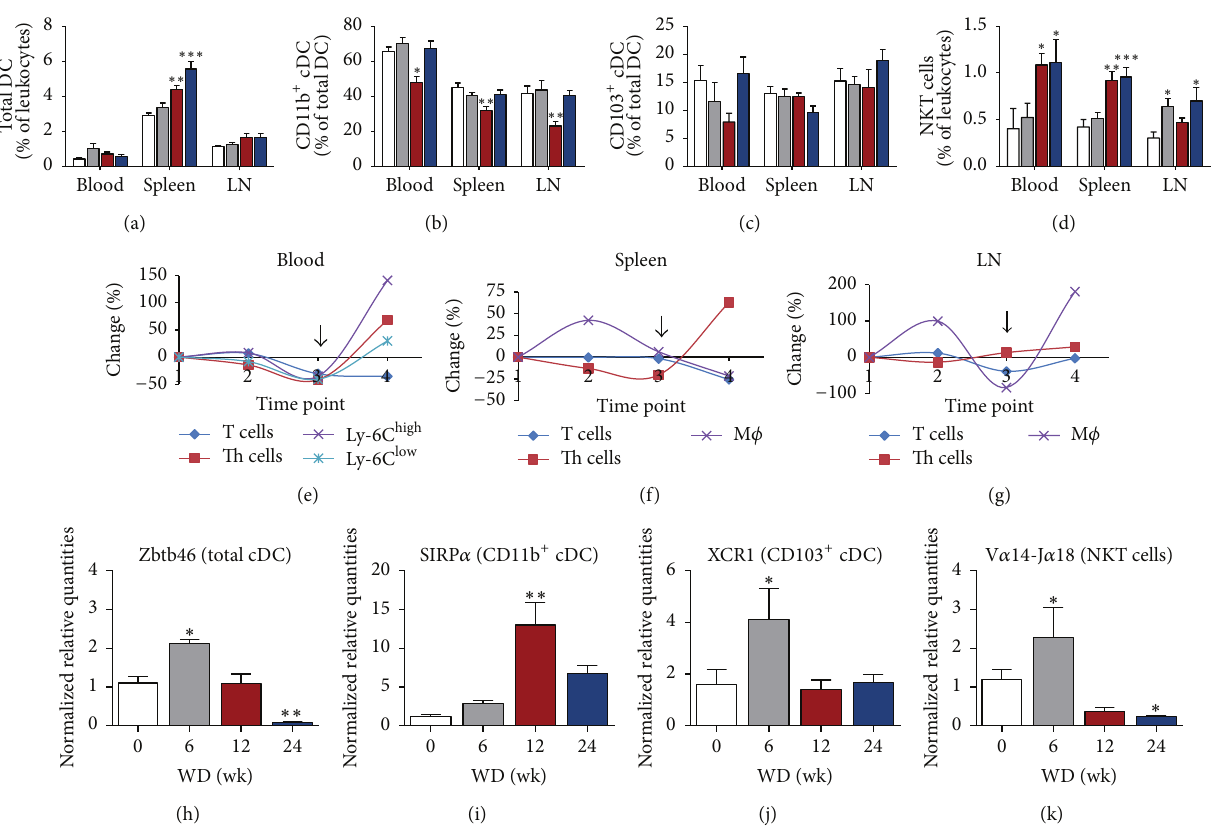
Figure2:Flowcytometryandgeneexpressionresultsofleukocyte(s)(subsets)inApoE −/− miceduringatherogenesis.Bargraphsrepresenting mice sacrificed after 0 wk (white bars, 𝑛 = 7 – 12 ), 6 wk (grey bars, 𝑛 = 9 – 12 ), 12wk (red bars, 𝑛 = 9 - 10 ), and 24 wk (blue bars, 𝑛 = 10 – 12 ) of WD. (a) Percentages of the total DC population. (b) Percentages of the CD11b + cDC subset within the total DC population. (c) Percentages of CD103 + cDC within the total DC population. (d) Percentages of NKT cells within the total leukocyte population. (e–g) Graphs showing fluctuations (as percentage change over time) in T cells, Th cells, and monocytes/macrophages in blood (e), spleen (f), and mediastinal LN (g) at different time points ( 1 = 0 wk, 2 = 6 wk, 3 = 12 wk, and 4 = 24 wk of WD). The arrow at time point 3 ( = 12 wk of WD)